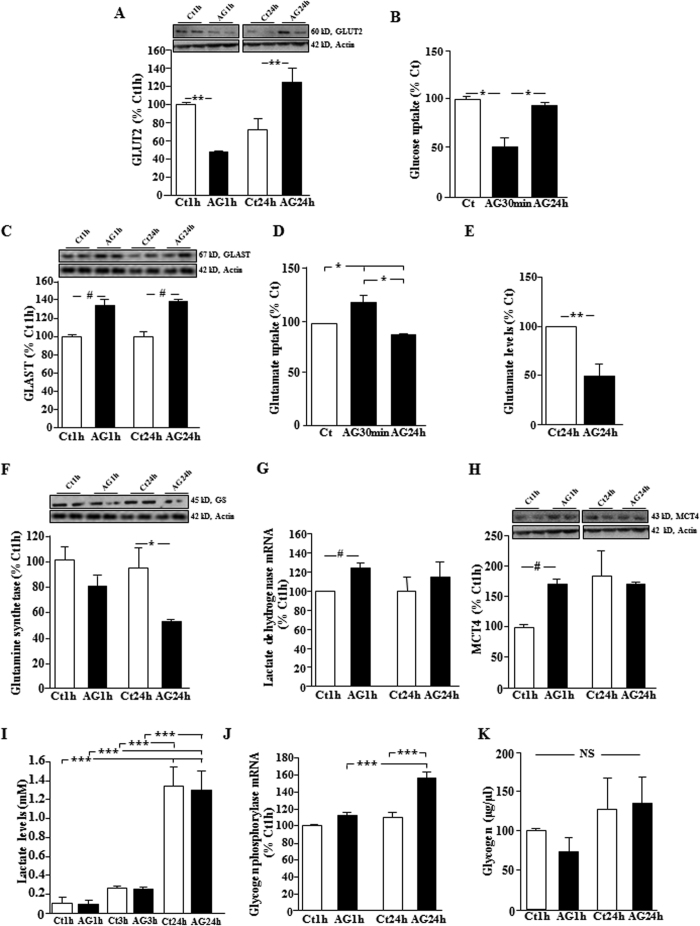
Response of hypothalamic astrocyte-enriched cultures to acyl-ghrelin treatment.Relative levels of (A) glucose transporter (GLUT)2, (B) glucose uptake, (C) glutamate-aspartate transporter (GLAST), and (D) glutamate uptake in primary astrocyte-enriched cultures from the hypothalamus of male Wistar rats treated with acyl-ghrelin (AG) or vehicle (Ct) for 1 h or 24 h. (E) Glutamate levels in the media of primary astrocyte cultures decreased after 24 h exposure to AG. Relative levels of (F) glutamine synthetase, (G) lactate dehydrogenase, (H) monocarboxylate transporter (MCT)4, (J) glycogen phosphorylase and (K) intracellular glycogen content were measured in primary astrocyte-enriched cultures from the hypothalamus of male Wistar rats treated with acyl-ghrelin (AG) or vehicle (Ct) for 1 h or 24 h. Lactate levels (I) were measured in the media of primary astrocyte cultures after 1, 3 or 24 h exposure to AG. *p < 0.05, #p < 0.01, **p < 0.001, ***p < 0.0001, NS = not significant. Representative Western blots are from the same gel although samples were not always contiguous within the gel.